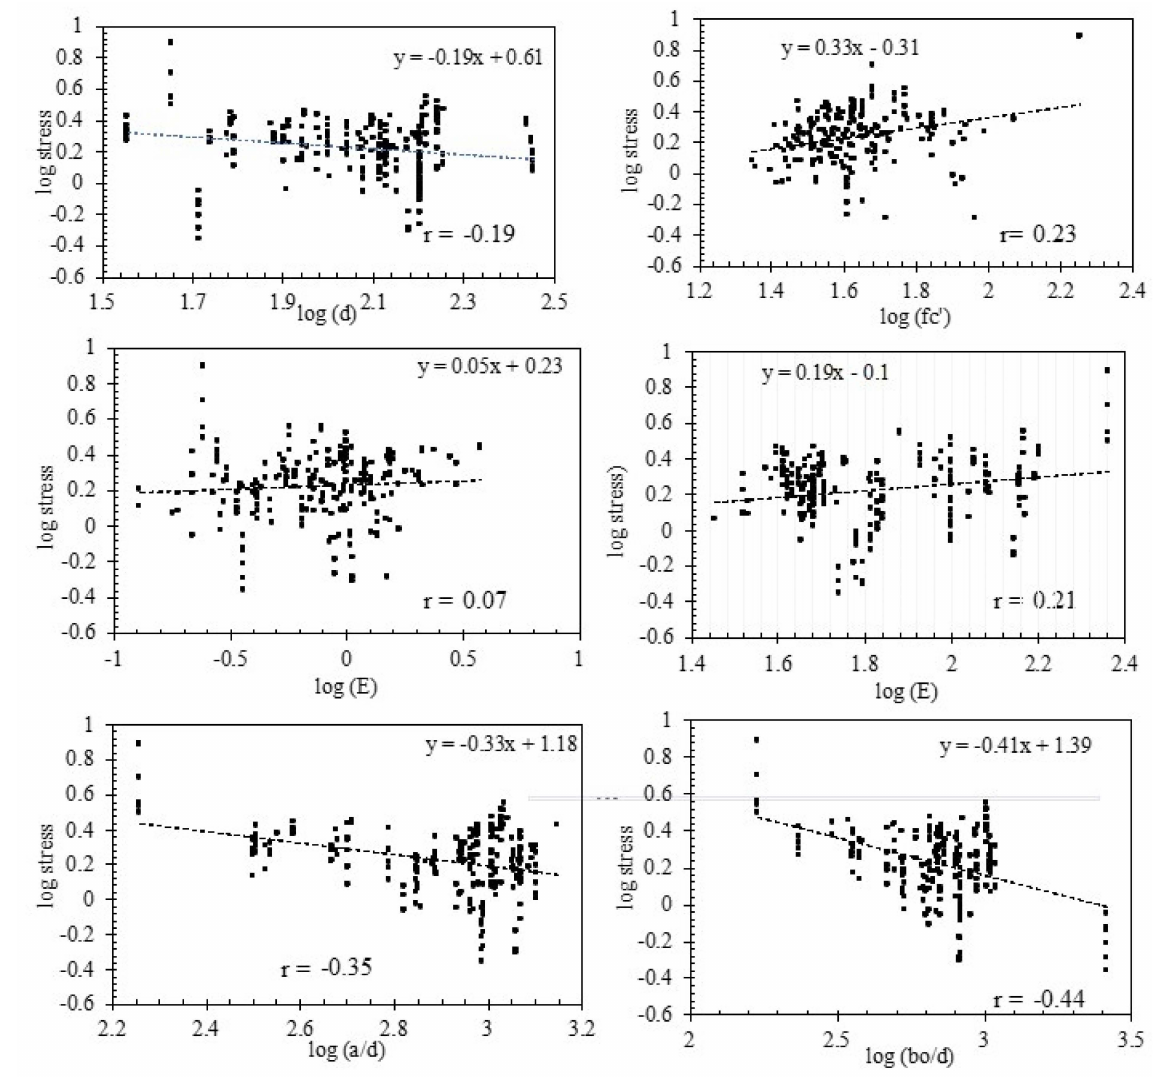
Figure 4. Stress versus basic